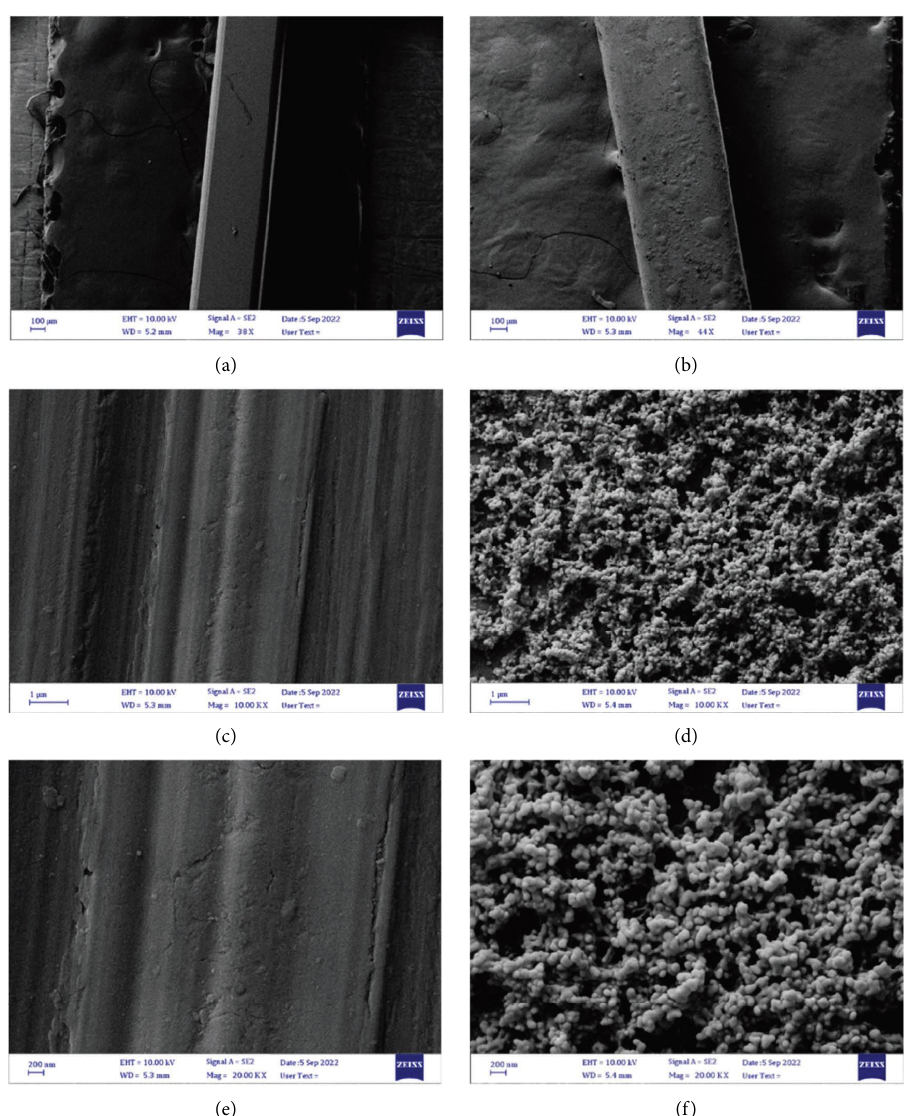
Figure 8: FeSEM images for the examined SSW at diferent magnifcation powers: (a, c, e) uncoated and (b, d, f)